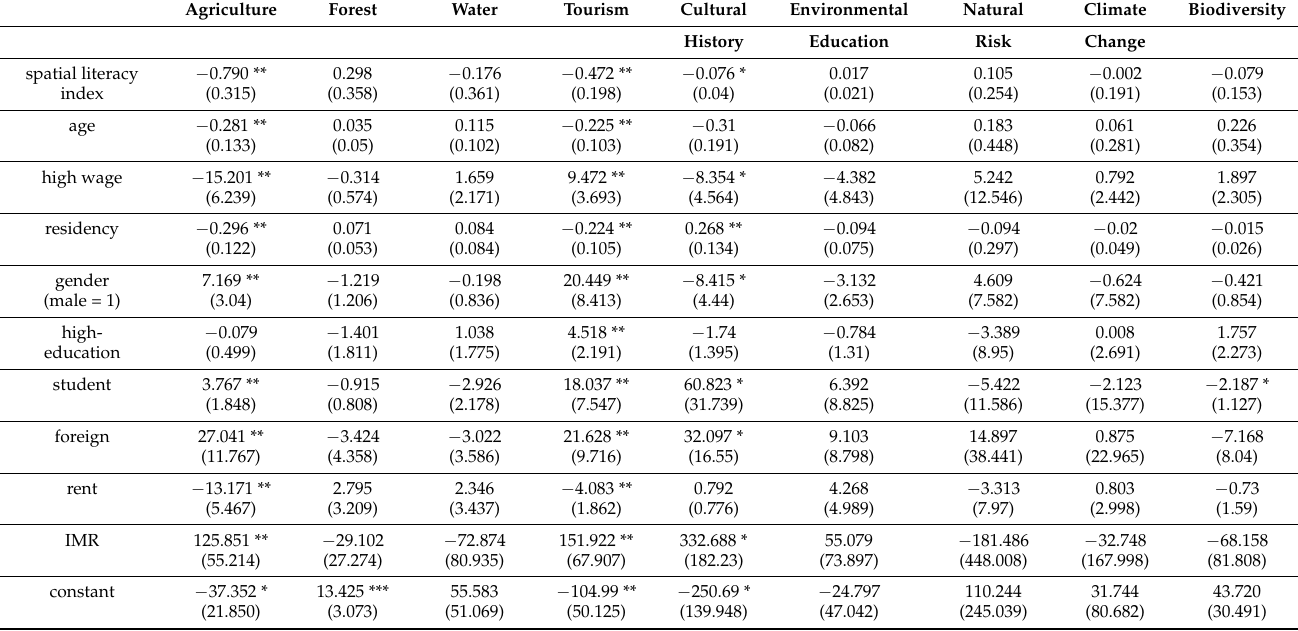
Table A5. Results for two-stage model. The second stage is an Ordinary Least Squares regression on the magnitude of investment for a respondent. By including the IMR in the regression, we are controlling for the probability that a respondent selects a given